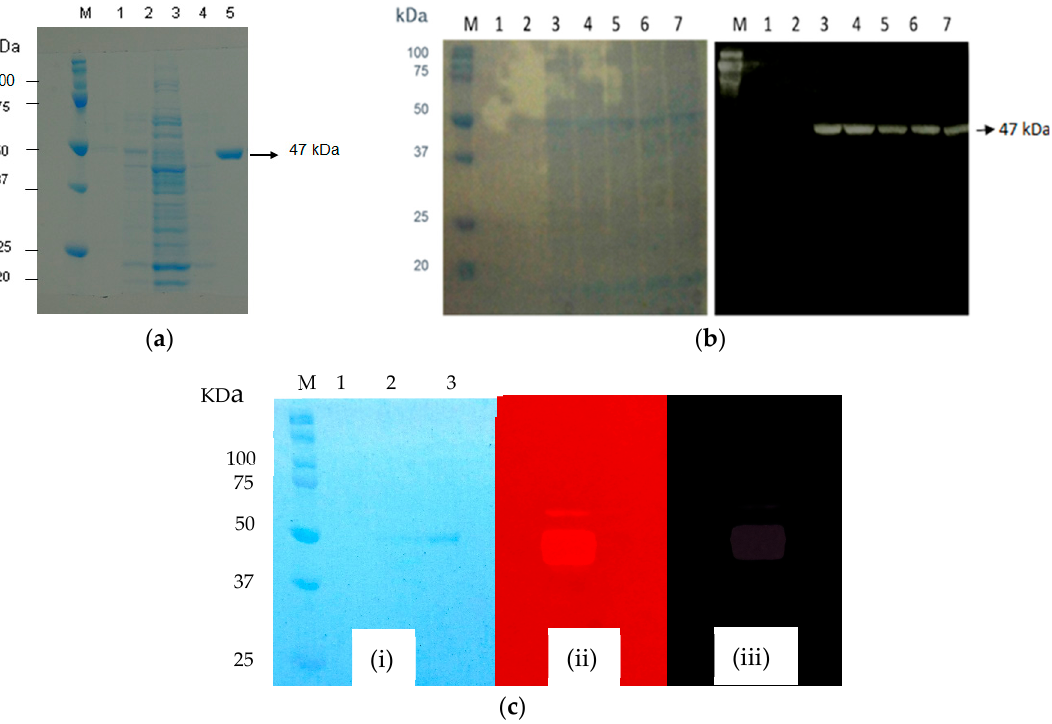
Figure 4. Determination of recombinant ManNj6-379. ( a ) SDS-PAGE of ManNj6-379: lane M, molec- ular mass markers; lane 1, supernatant of S. lividans 1326 wild type; lane 2, crude cell-free extract of S. lividans 1326 harboring pUC702- manNj6-379 ; lane 3, crude cell-free extract of S. lividans 1326 harboring pUC702- manNj6-379 ; lane 4, wash fraction with Ni Sepharose excel; lane 5, purified ManNj6-379. ( b ) Western Blotting and: lane M, molecular mass markers; lane 1, crude cell-free extract of S. lividans 1326 harboring pUC702- manNj6-379 at 0 h; lane 2, 24 h; lane 3, 48 h; lane 4, 72 h; lane 5, 96 h; lane 6, 120 h; and lane 7, 144 h of cultivation. ( c ) Zymogram of ManNj6-379: lane M, molecular mass markers; lane 1, supernatant of S. lividans 1326 wild-type; lane 2, supernatant S. lividans 1326 harboring pUC702- manNj6-379; lane 3, purified ManNj6-379; (i) Coomassie Blue R-250 stain; (ii) 0.01% (w/v) Congo Red; (iii) 0.01 (w/v) Congo Red + Acetic acid glacial.